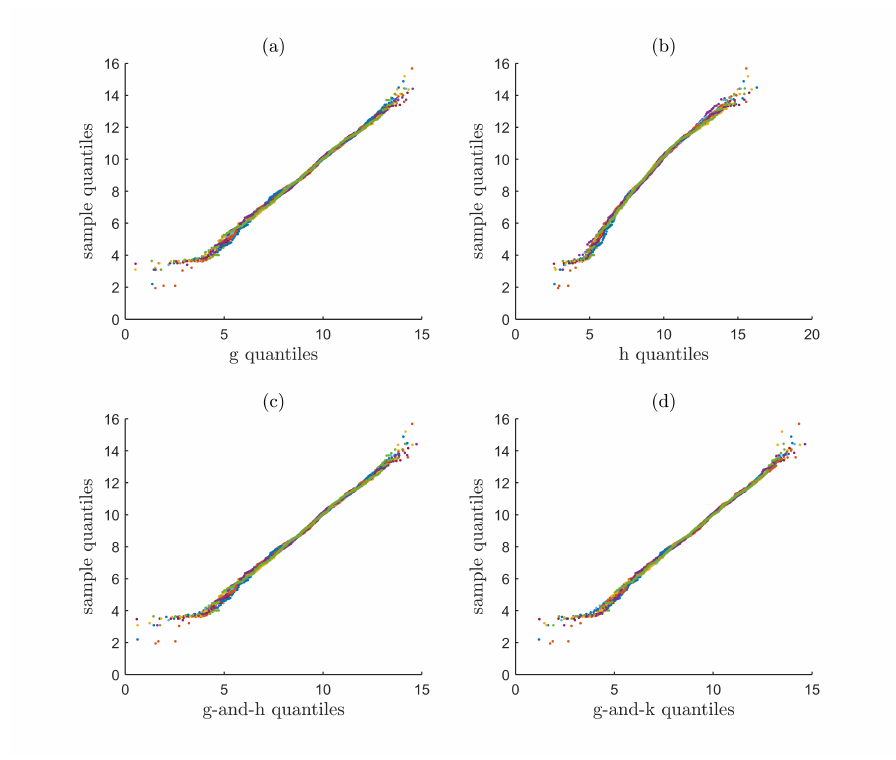
Figure 2. Q-Q plots of monthly partitioned log payments for 2003, where the sample quantiles are plotted against the model quantiles. The panels ( a ), ( b ), ( c ), and ( d ) correspond to the g, h, g-and-h, and g-and-k models, respectively.